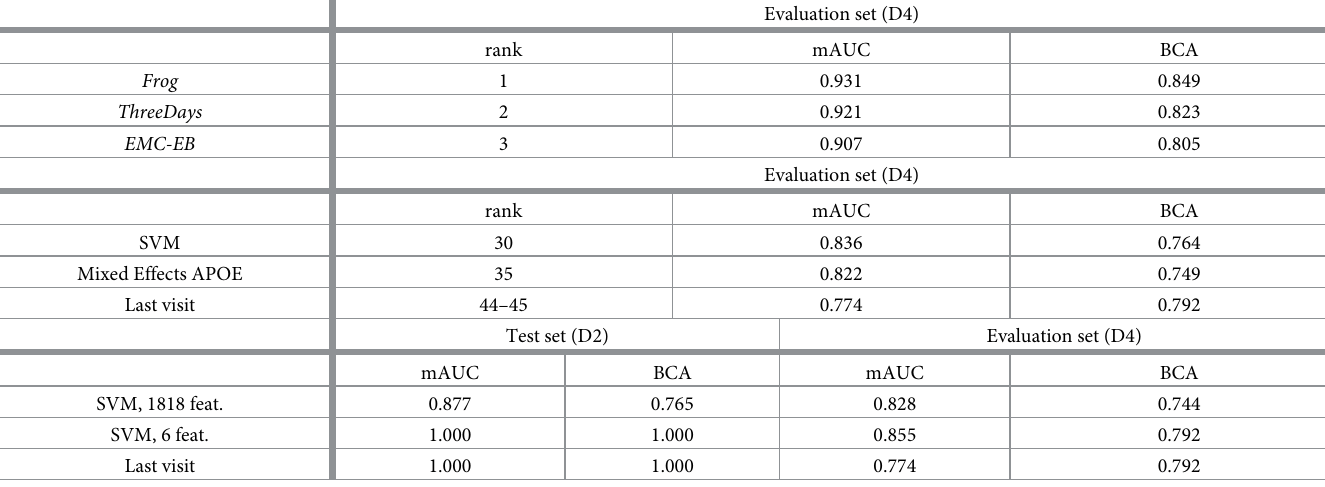
Table 2. Performance reported in the TADPOLE Challenge on D4. Performance obtained with the benchmark methods in D2 and D4.